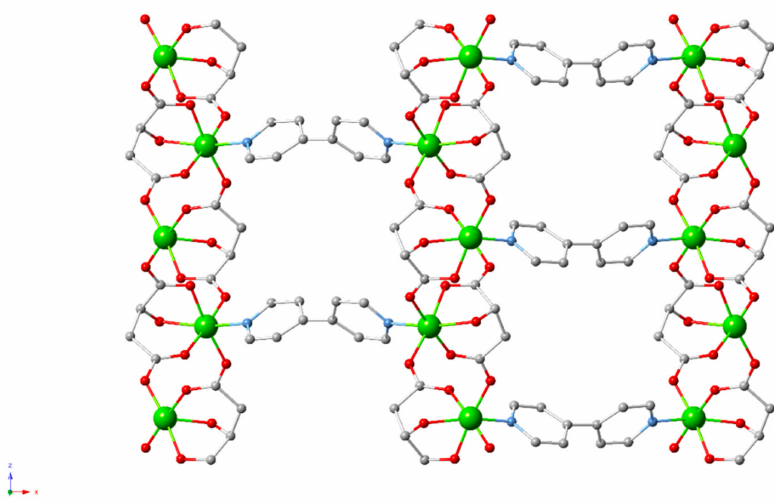
Figure 13. Cu and Ni-based homochiral L-malate MOFs [130].